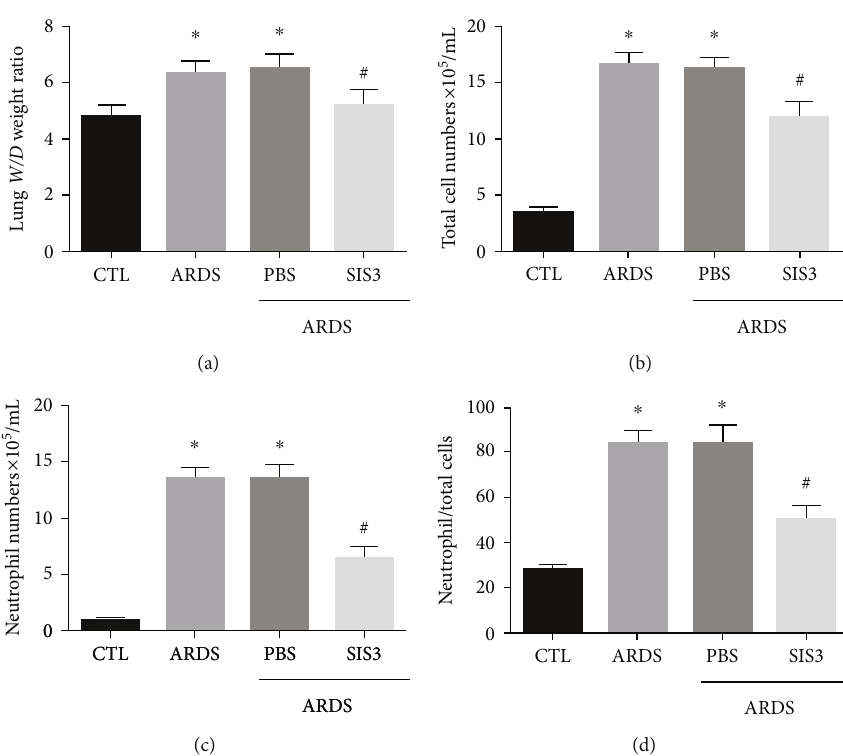
Figure 4: SIS3 pretreatment alleviates lung injury and focal in fl ammation in LPS-induced ARDS. (a) BALF was collected 24 h after intratracheal instillation of LPS. The alternation of the alveolar capillary barrier was weakened by SIS3 pretreatment in ARDS rats, which was seen in an increase of the lung W / D ratio. (b – d) The total cells, neutrophils, and neutrophil ratio in the BALF were higher in the ARDS group than in the control group. The values were also lower in the ARDS + SIS3 group when compared to the ARDS group, respectively. The data are presented as the means ± SD ( n = 10 ). ★ P < 0 : 05 vs. CTL; # P < 0 : 05 vs.